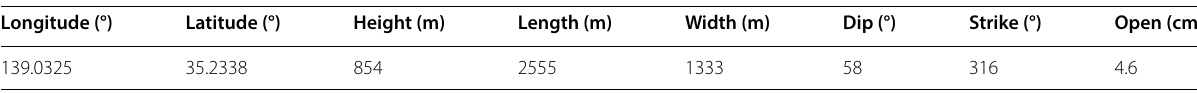
The location of the crack shown in the table is the upper south corner